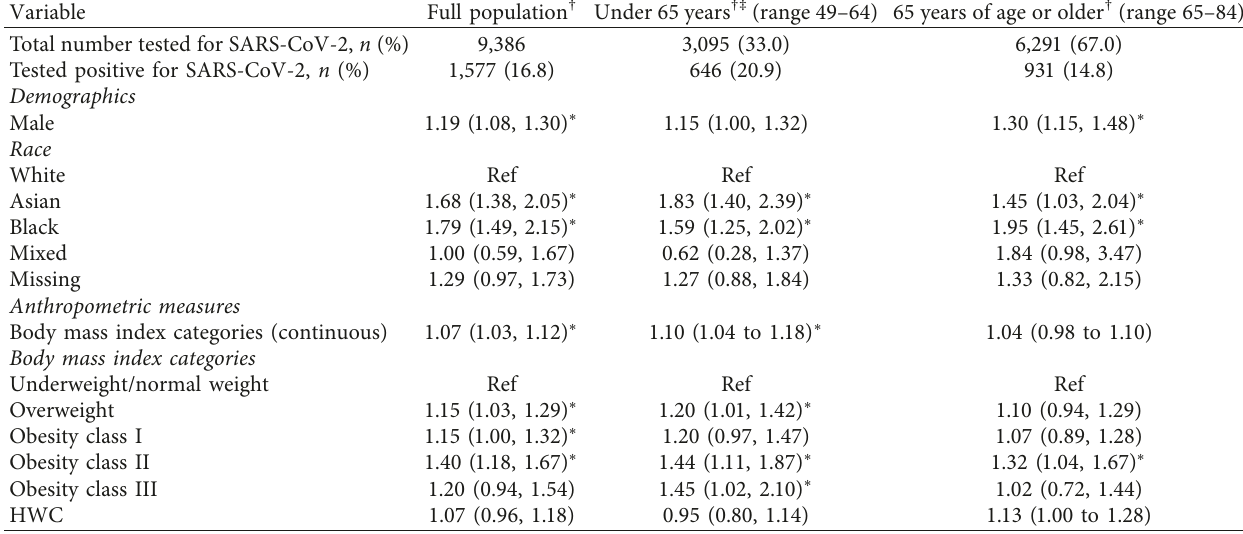
Table 3: Association between measures of adiposity and testing positive for SARS-CoV-2 overall and stratified by older age.